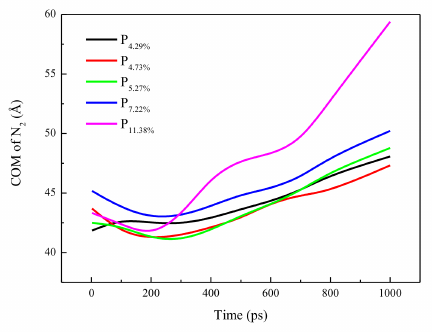
Figure 3. The location of the center of mass of N 2 .